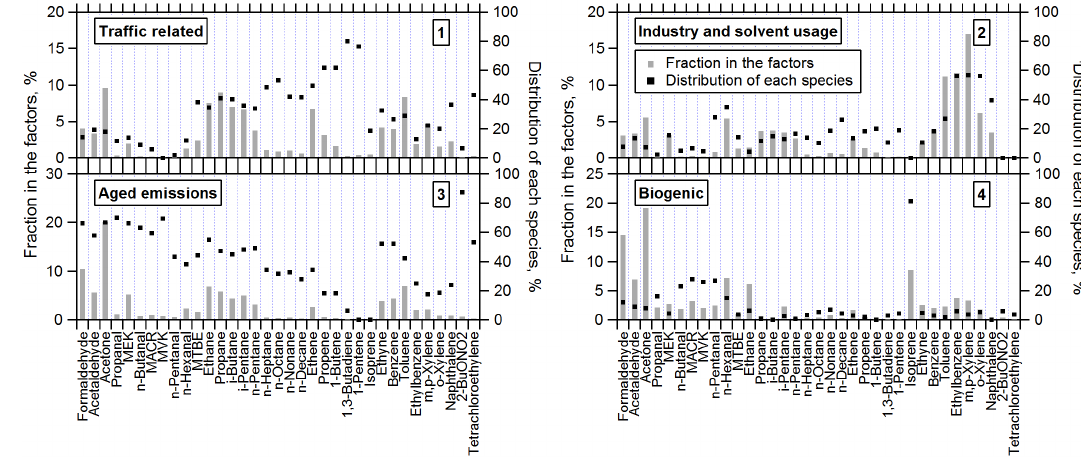
Fig. 2. Profiles of the four factors resolved by the PMF model and the distributions of species among these factors in summer.